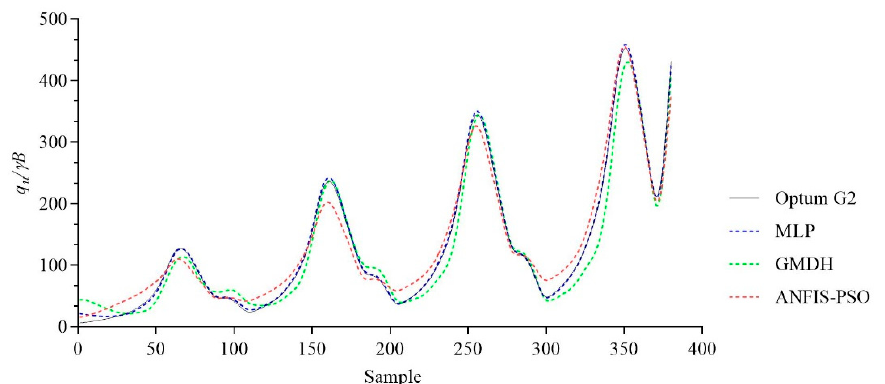
Figure 16. Performance of the ML algorithms: comparison between the FELA results and the forecasts provided by the three algorithms for 1% randomly selected data, in terms of the seismic bearing capacity Q = q u / γ B of the shallow strip footing.